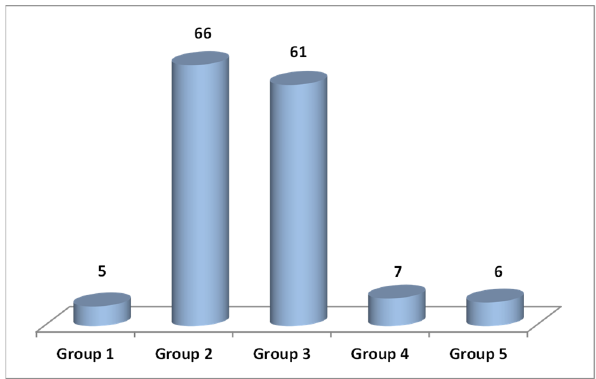
Figure 1. Number of cities of each group.